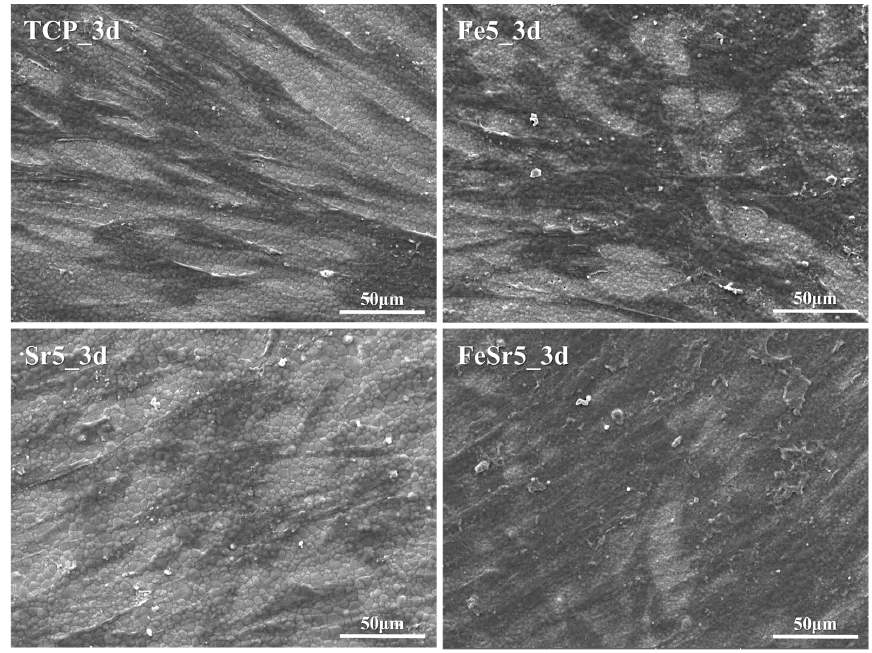
Figure 16. Magnified SEM images of TCP, Fe5, Sr5, and FeSr5